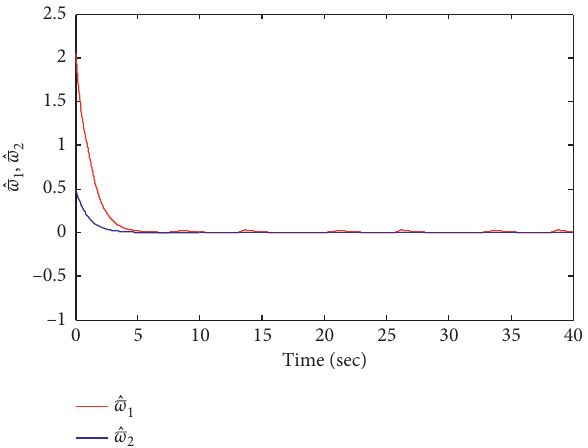
Figure 11: Estimated parameters 􏽢 ϖ